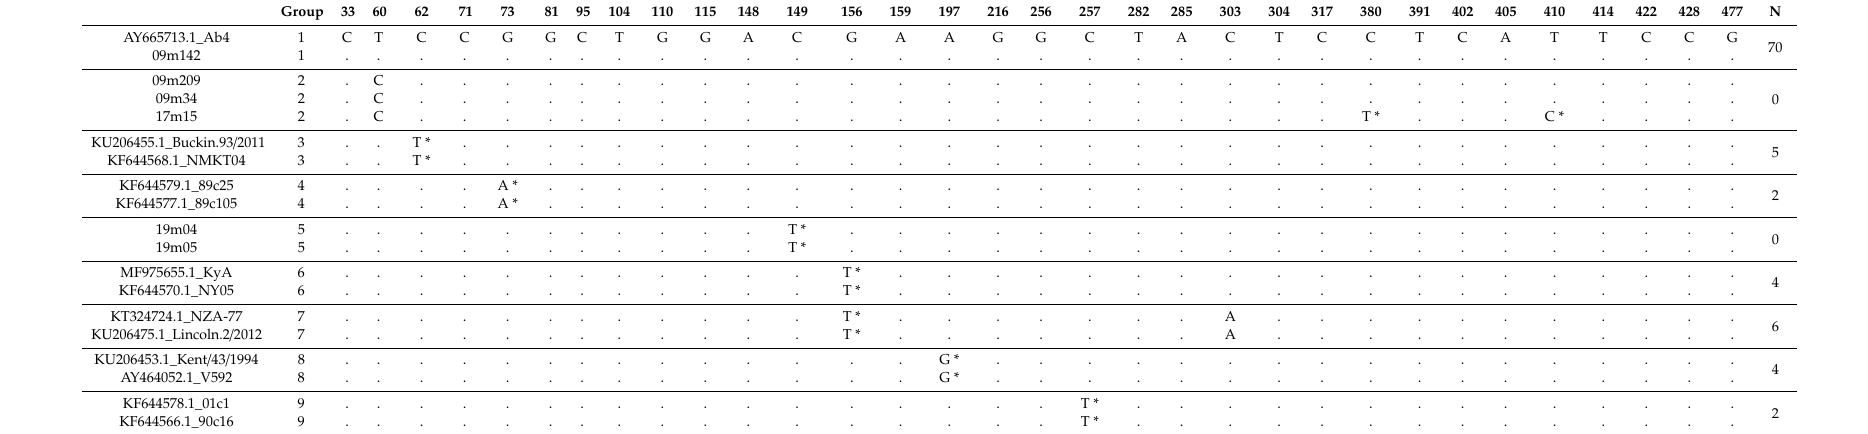
Table 4. Variations of the 483 bp sequences of the ORF34 gene are